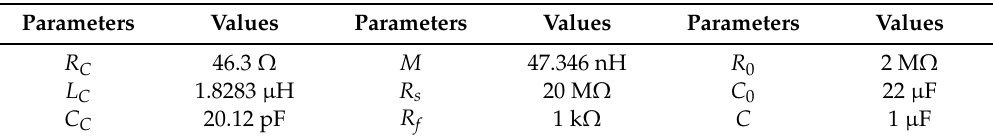
Table 4. Parameters of the PCB Rogowski Coil